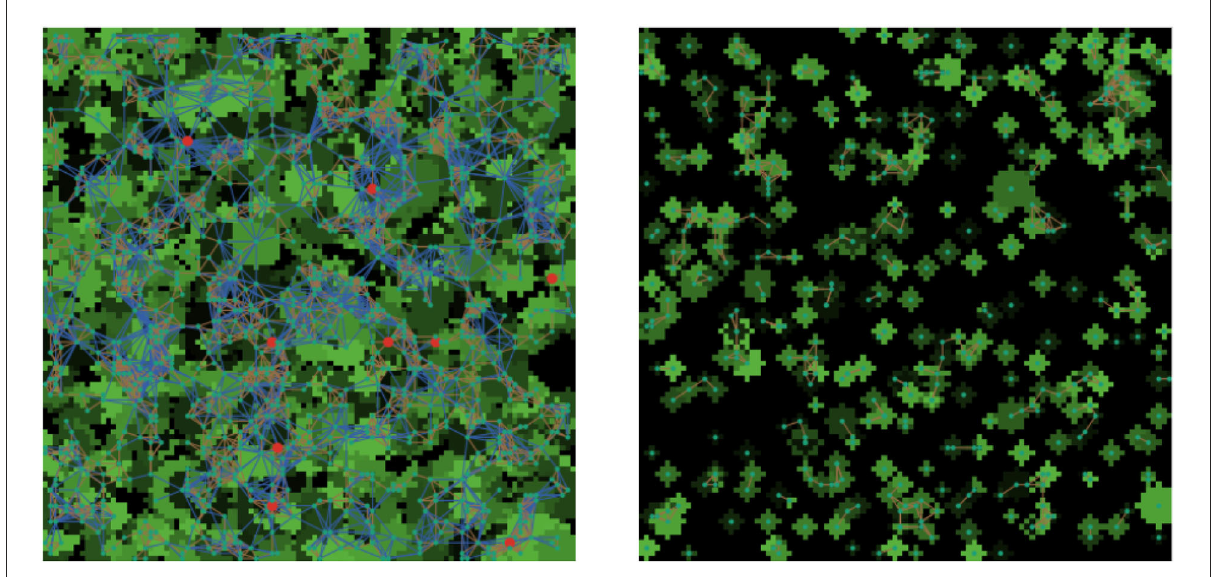
FIGURE4 Tree survey data from the study site is visualized in the model simulation setup, including the unburned forest (left) and the burned forest (right) . The red dots represent the fruiting trees. We computed a network comprised of links representing the tree connectivity, which is determined by the (i) overlap (blue lines) and (ii) distance (brown lines) between trees. The link color also represents the type of arboreal movement which is available to the orangutan (sway between close trees and brachiate through overlapping canopies).